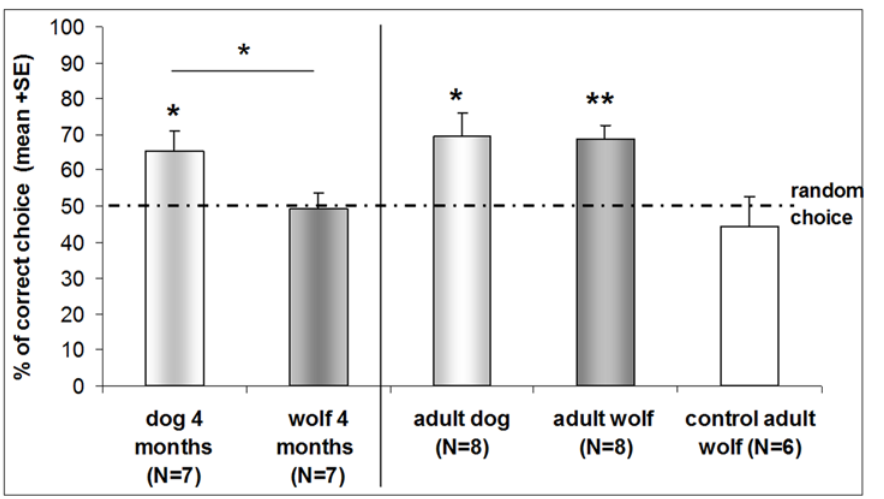
Figure 1. Study 2 and 3: The performance of young and adult wolves and dogs in distal momentary pointing trials. In all groups, success was compared to random choice (50%) with one sample t test. * P , 0.05, ** P , 0.01.